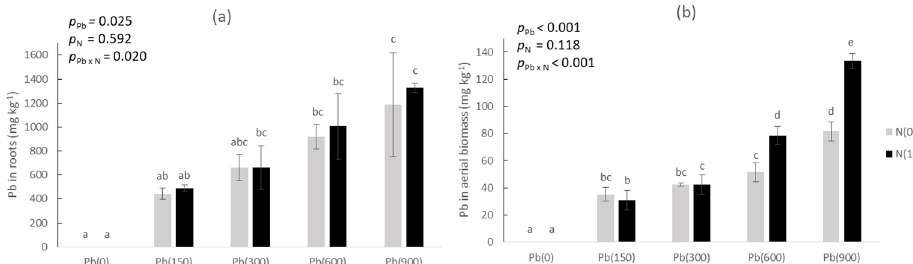
Figure 3. Pb concentrations ( a ) in roots, and ( b ) in aerial biomass in purslane as affected by the addition of Pb (0, 150, 300, 600, and 900 mg kg − 1 soil) and with (N1) and without added nitrogen (N0). Different letters denote significantly different treatments at p < 0.05.